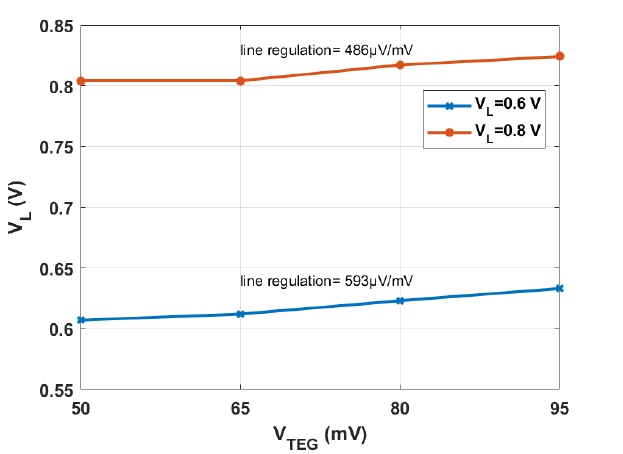
Figure 13. Line regulation of SI boost regulator at I L = 10 µ